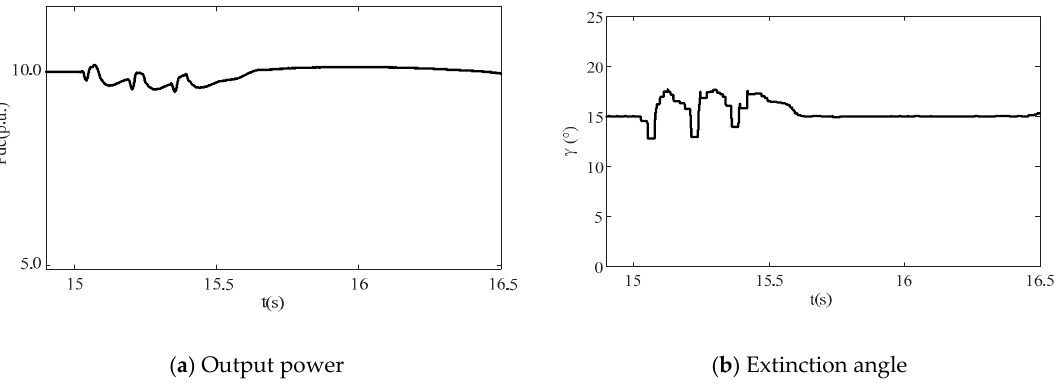
Figure 7. Operation characteristic of DC 2 under continuous CFs.